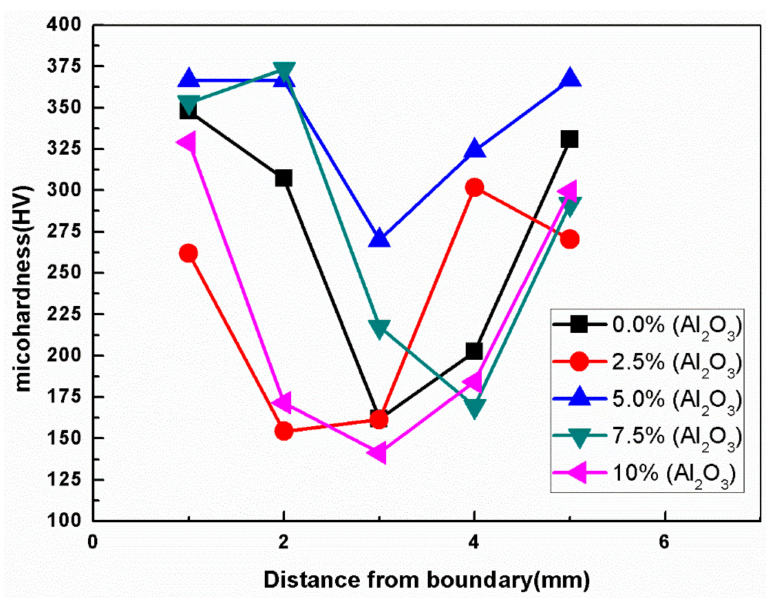
Figure 12. Microhardness distribution of CoCr alloy doped with di ff erent percentages of Al 2 O 3